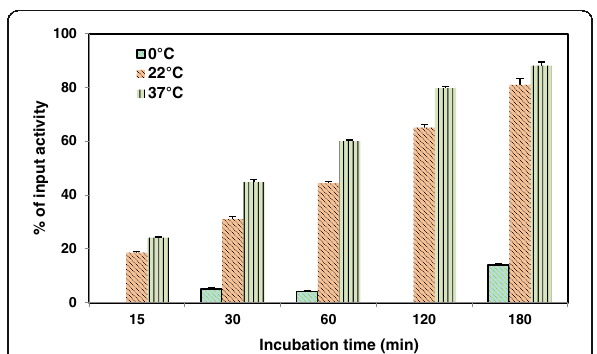
Fig. 4 The B16F1 cells (~2.5 × 10 5 cells/well) were incubated with 4-[ 18 F]FEBZA for 15, 30, 60, 120, and 180 min at 0, 22, and 37 °C. Significantly higher binding was noted at 22 and 37 °C as compared to that at 0 °C. The data is expressed as percent of total radioactivity added to each well and the values are the mean ± SD ( n = 4 wells). Data for 0 °C was determined only at 30, 60, and 180